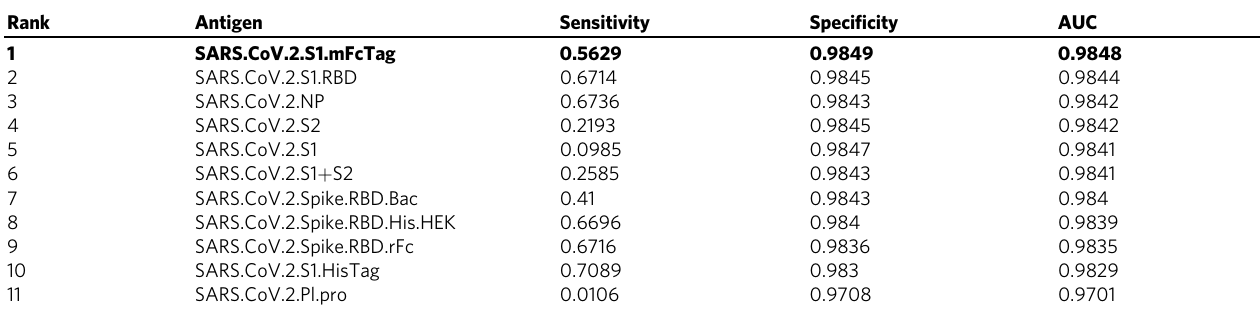
Table 1 Ranking of SARS-CoV-2 antigens for IgG.